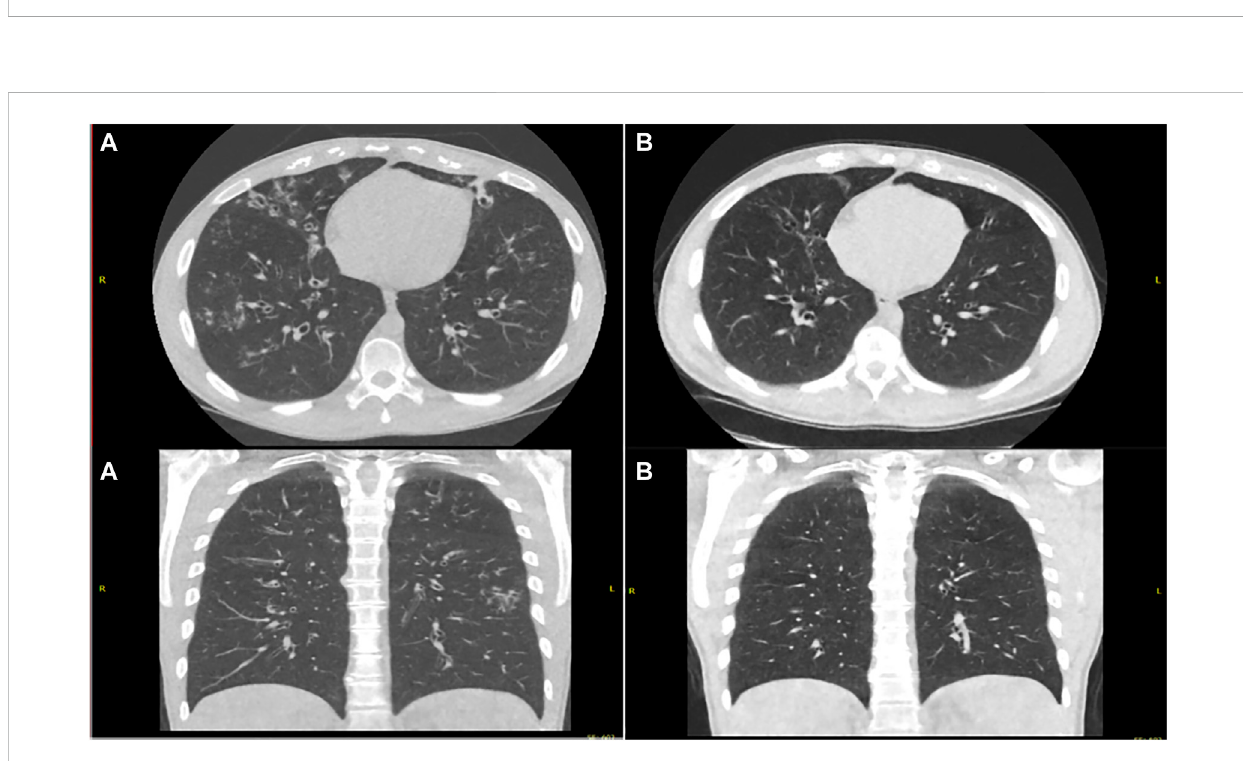
FIGURE 3 Ultra-Low Dose CT Thorax pretreatment (A) and post modi fi ed dose regimen (B) showing reduced burden of bronchiectasis, reduced caliber of bronchiectatic airways, decreased bronchial wall thickening and resolution of tree in bud opaci fi cation changes.